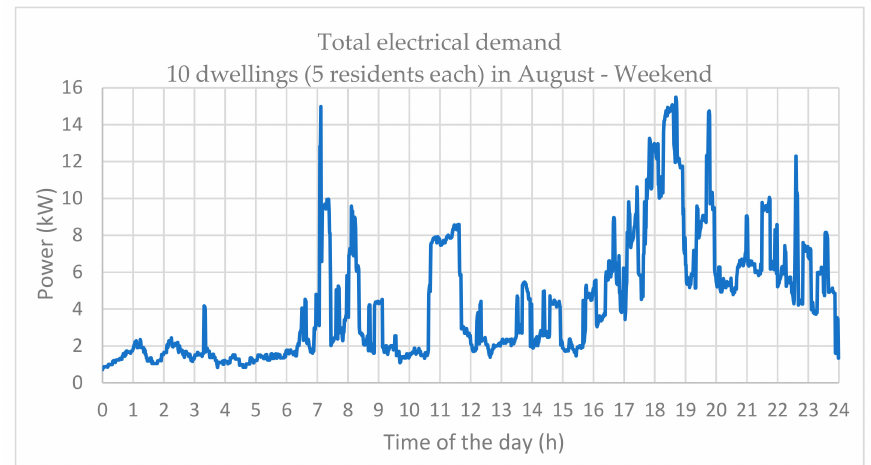
Figure 15. 24-h total electrical demand—Profile 3.